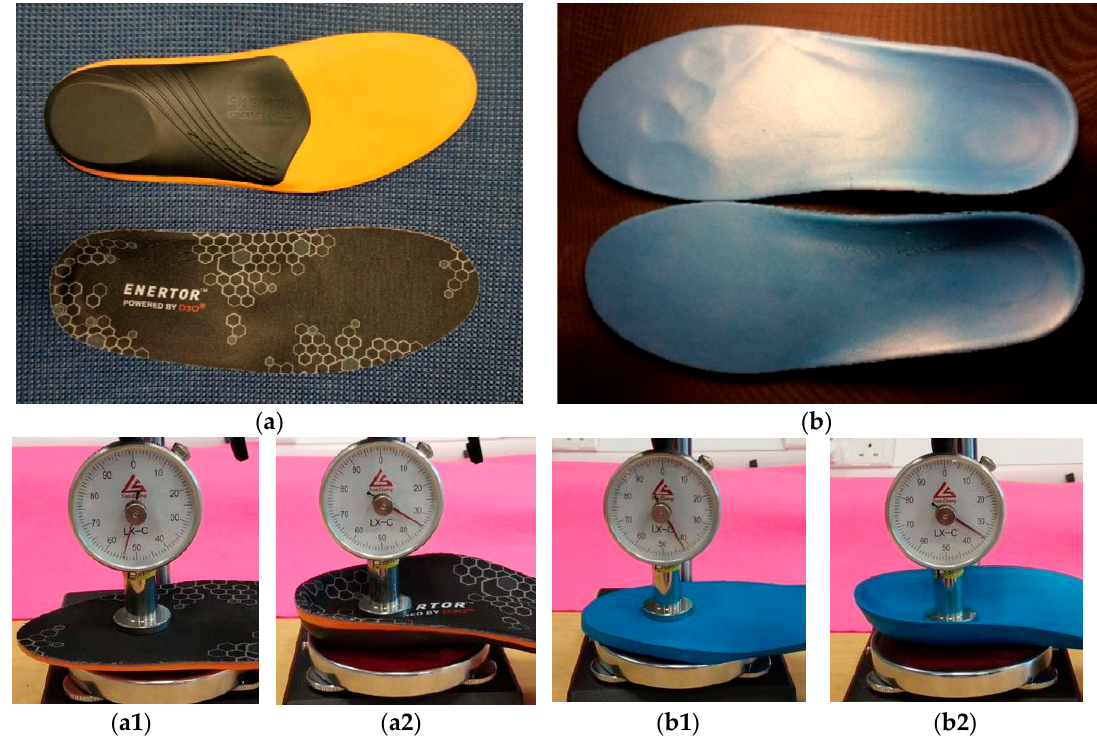
Figure 1. ( a ) Enertor TM D3O ® insole (bottom side (the back is composite) and top side). Shore hardness (measured from top) 55C (forefoot area) ( a1 ) and 37C (heel area) ( a2 ); ( b ) Commercial ethylene-vinyl acetate (EVA) insole (uniform foam, (bottom) original and (top) after heating and stepping atop to fit/program) (reproduced from [10] ). Shore hardness (measured from top) 42C (forefoot area) ( b1 ) and 35C (heel area) ( b2 ) (slight difference between the forefoot and heel should be due to the bottom of the heel is not a flat surface as the forefoot).